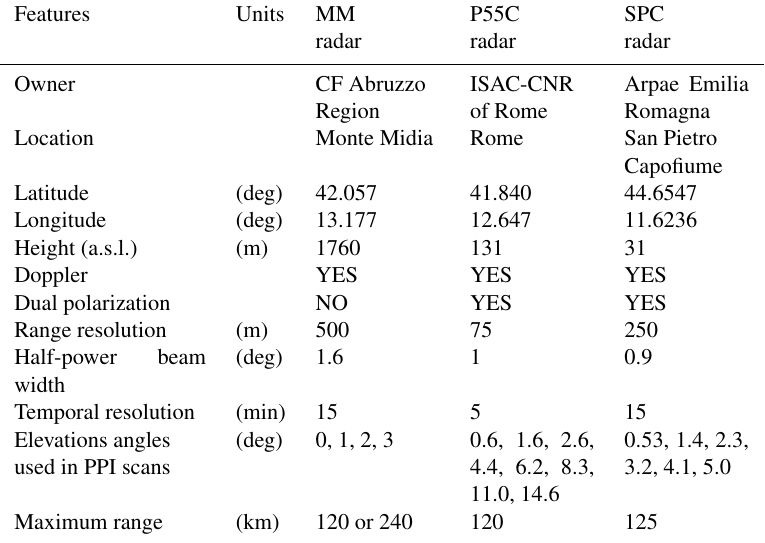
Table 1. Technical characteristics of the three radars whose reflectivity have been assimilated during IOP4.